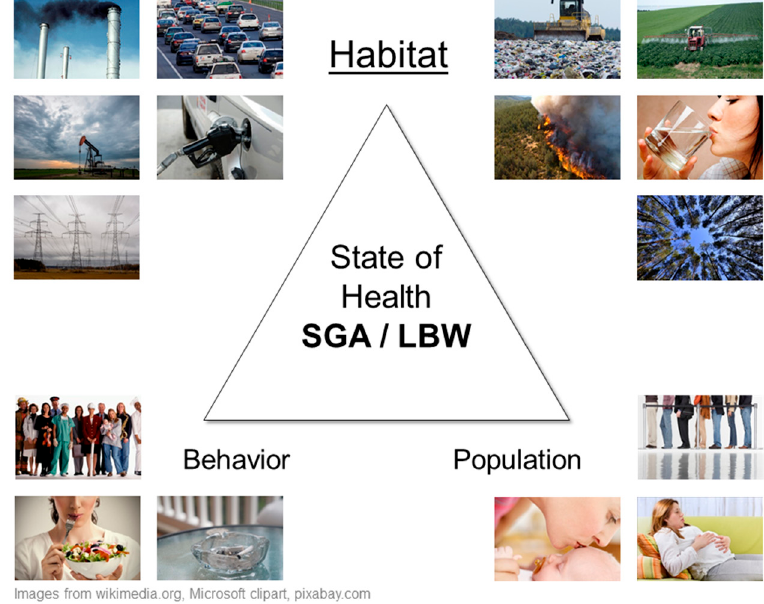
Figure 3. Meade’s triangle of human ecology for maternal exposures and small for gestational age (SGA) and low birth weight (LBW).